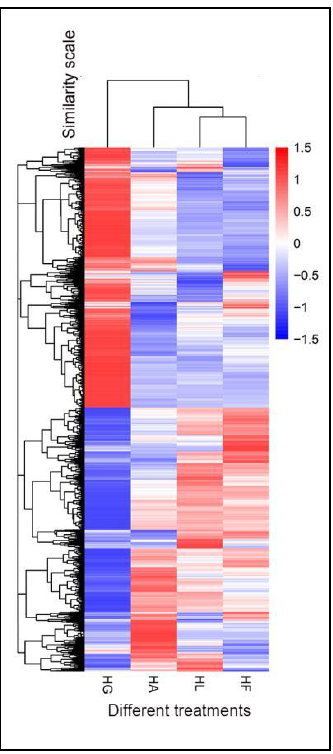
Figure 6. Cluster analysis of DEGs. The Y axis represents relative expression, the red and blue represent up-regulation and down-regulation. HF: the group of addition of Fe 2+ together with high light treatment; HL: high light treatment group; HA: the group of addition of acetate together with high light treatment; HG: green growth group.